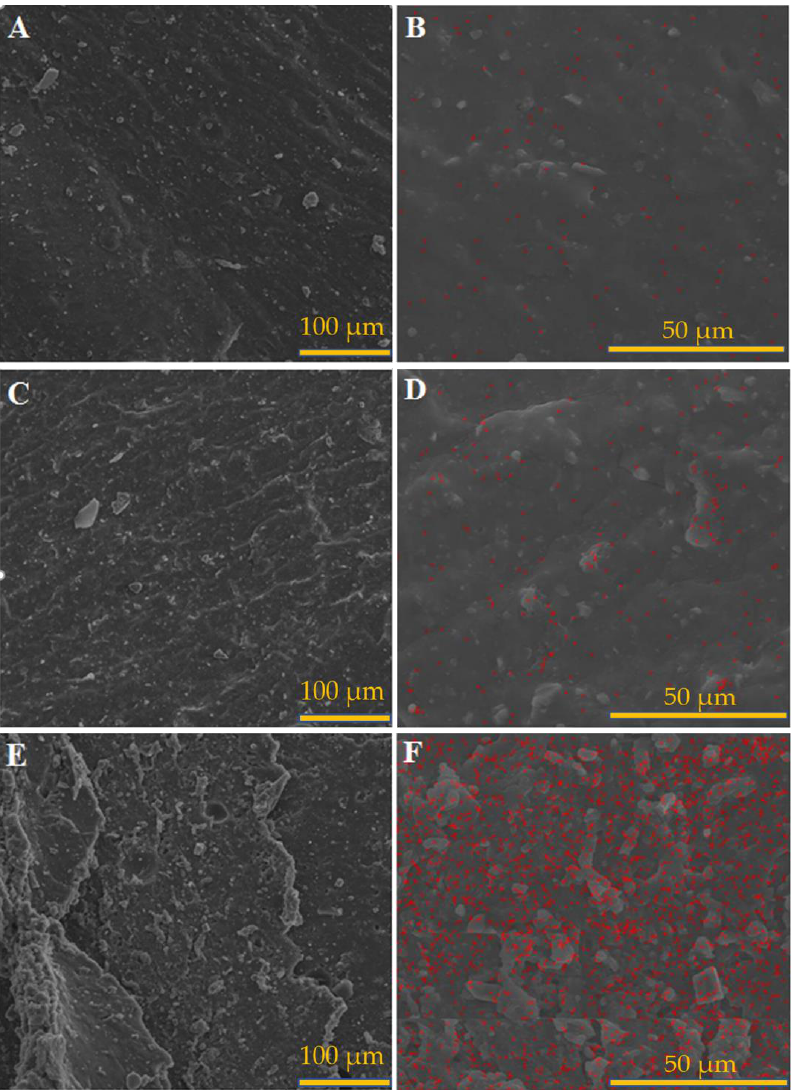
Figure 2. FESEM images for ( A ) LPS/CNPs 1%, ( C ) LPS LPS/CNPs 3%, ( E ) LPS/CNPs 5%, and the distribution map for Si element for ( B ) LPS/CNPs 1%, ( D ) LPS LPS/CNPs 3%, ( F ) LPS/CNPs